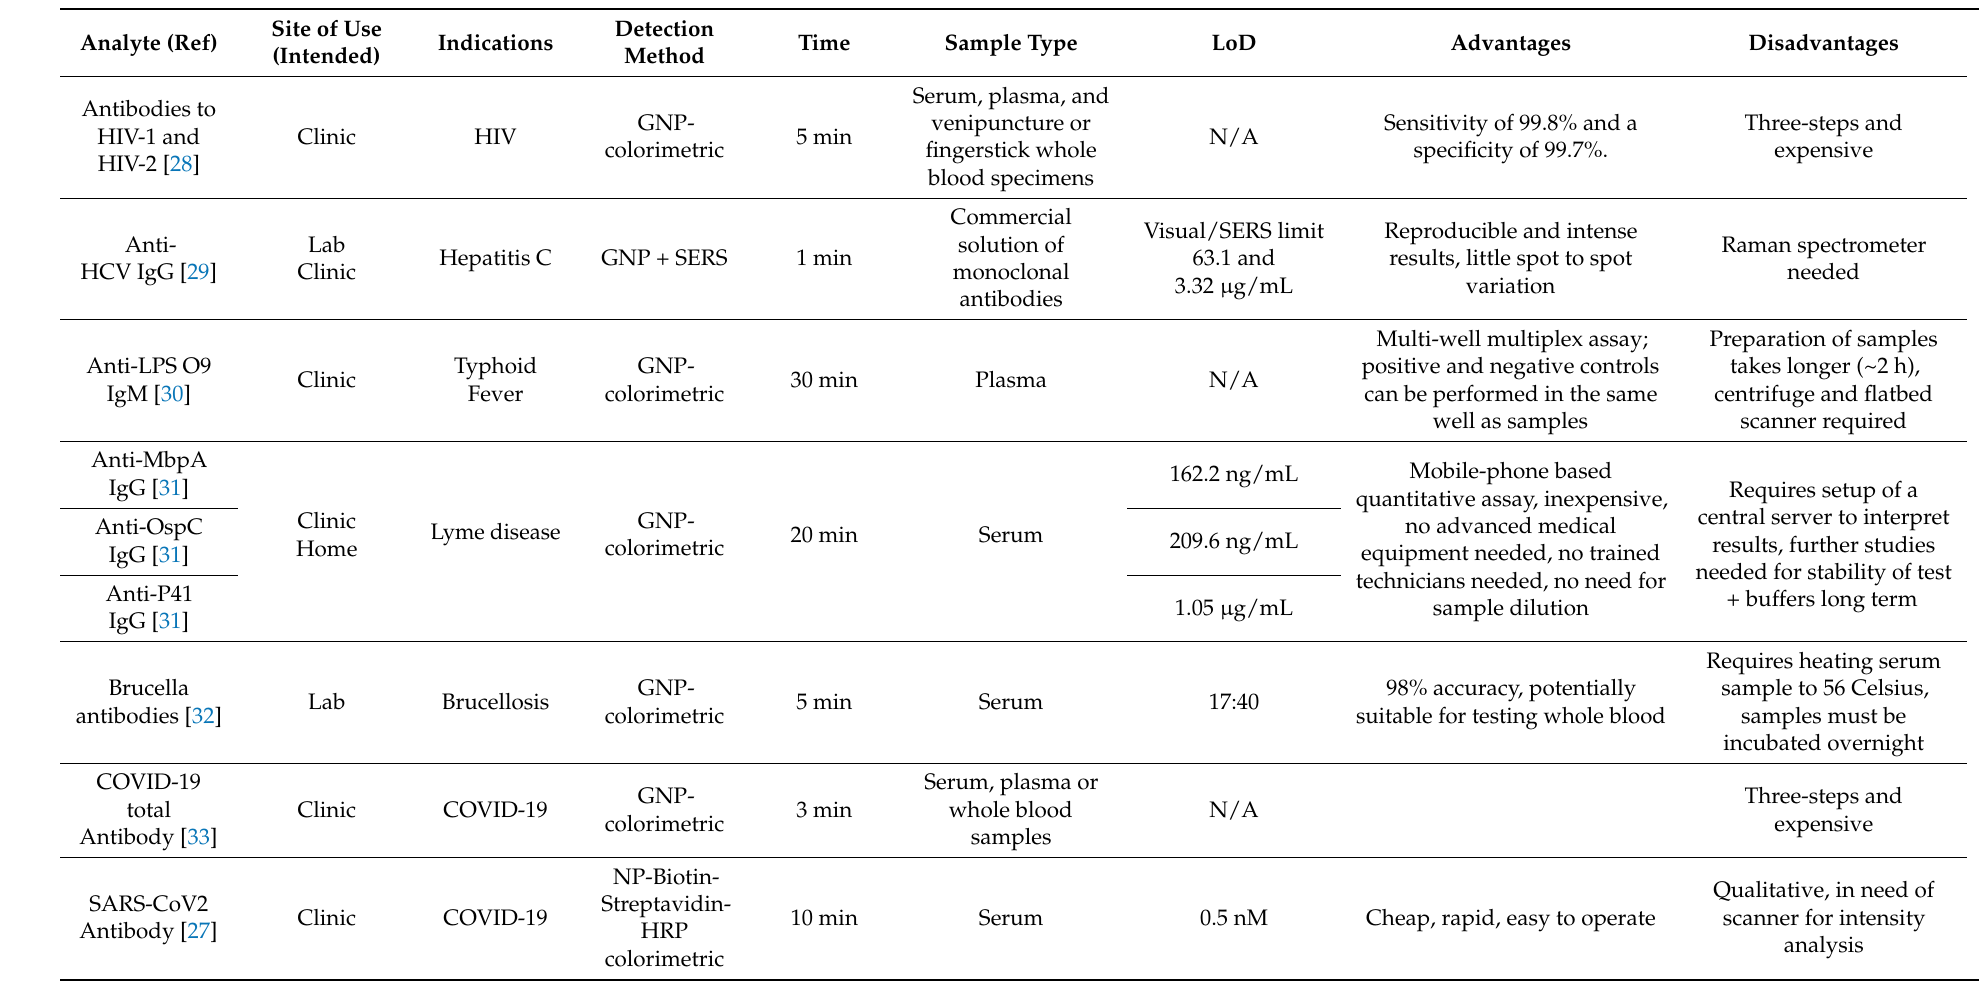
Table 2. Vertical flow assays for antibody